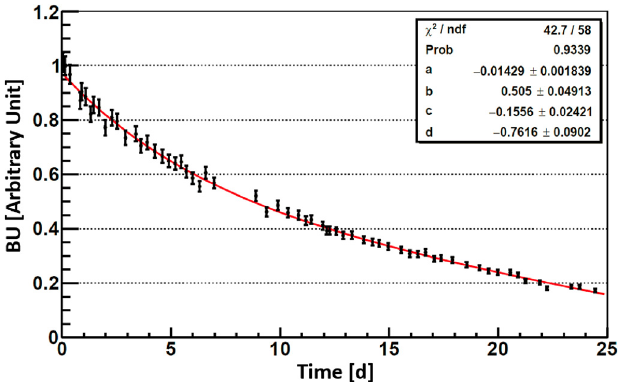
Fig. 1. The time evolution of the amount of fi ssile material in the target, so-called Burn-Up ( BU ) for Exp.2. The experimental points, in black, fi tted by equation (2),